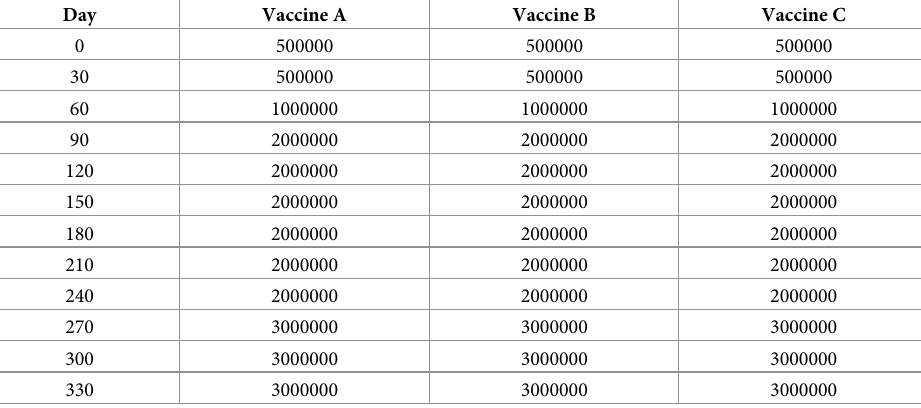
Table 3. Units of Vaccines of each type that are assumed to become available in batches at specific days. Day